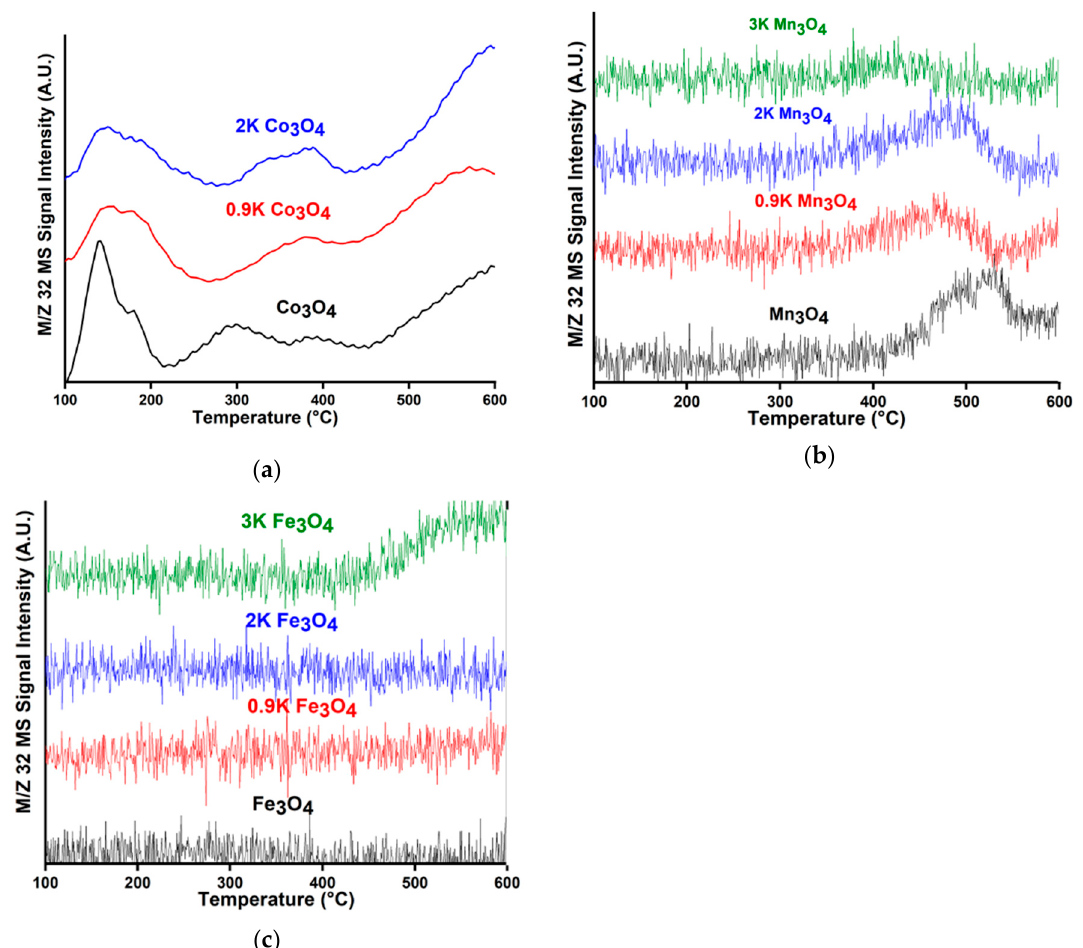
Figure 4. Oxygen temperature-programmed desorption (O 2 -TPD) profiles as a function of temperature over ( a ) Co 3 O 4 -based catalysts, ( b ) Mn 3 O 4 -based catalysts, and ( c ) Fe 3 O 4 -based catalysts with varying amounts of K promotion (0–3 wt.% K).